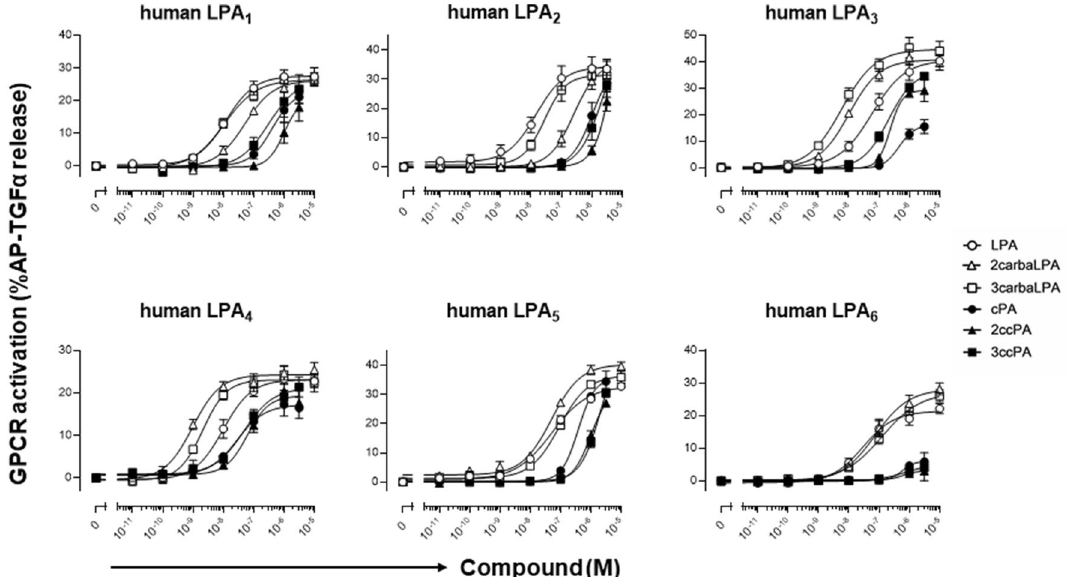
Figure 4. Agonistic activity of 2-carba-lysophosphatidic acid (2carbaLPA) and cyclic phosphatidic acid (cPA) analogues toward six lysophosphatidic acid (LPA) receptors. 293A cells expressing LPA receptors were stimulated with the indicated concentration of LPA, 2carbaLPA, and cPA analogues. Receptor-specific alkaline phosphatase-tagged transforming growth factor-α release was calculated by subtracting the responses in the empty vector-transfected cells from those in the receptor-expressing cells. Data are represented as standard error of the mean of three independent